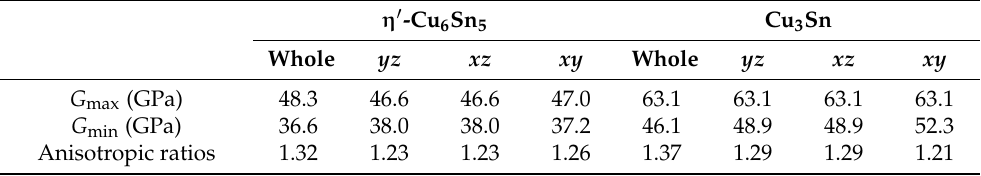
Figure 5. Cross-sections of G in the yz , xz , and xy planes for η (cid:48) -Cu 6 Sn 5 and Cu 3 Sn: ( a ) the yz plane; ( b ) the xz plane; ( c ) the xy plane. The solid and dotted lines denote the maximum and minimum values, respectively. The green and red lines denote the cross-sections for η (cid:48) -Cu 6 Sn 5 and Cu 3 Sn, respectively. Table 7. The anisotropic ratios, maximum and minimum values of G for η (cid:48) -Cu 6 Sn 5 and Cu 3